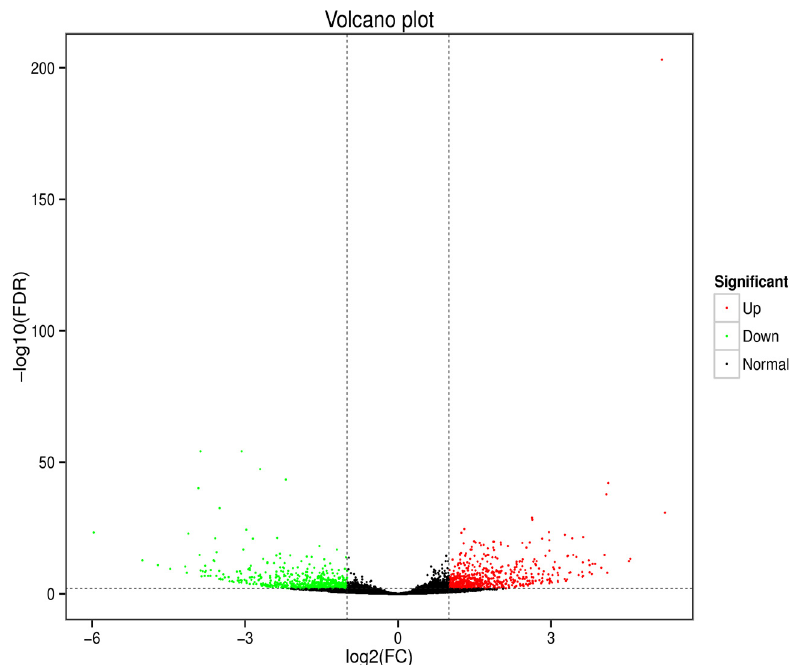
Figure 2. Volcano plot of the differentially expressed genes. The fold change of gene expression between the 5-AZA + bacterial treated group and the control group is represented by the horizontal ordinate. The vertical ordinate exhibits the statistical significance of the change in gene expression. Each gene is represented by a point on the plot, with the blue and red points representing the genes that were significantly down-regulated and up-regulated, respectively.